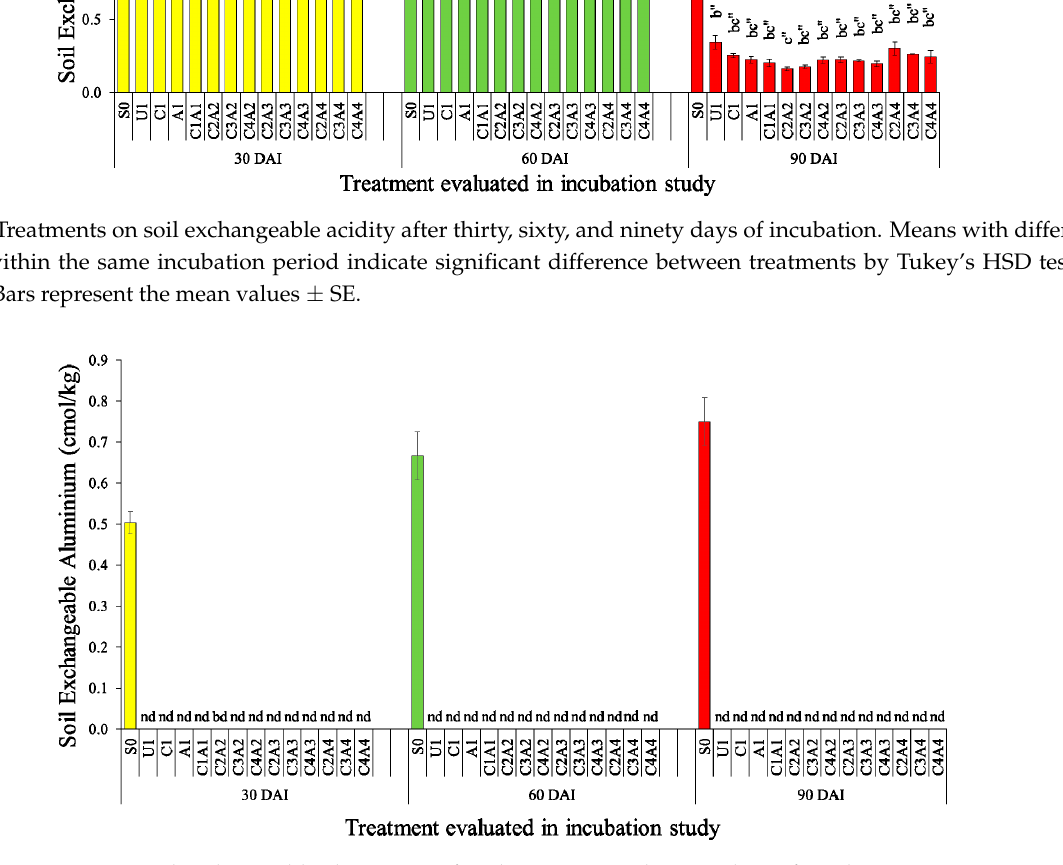
Figure 5. Treatments on soil exchangeable aluminium after thirty, sixty, and ninety days of incubation. Bars represent the mean values ±SE (Note: nd = not determine).